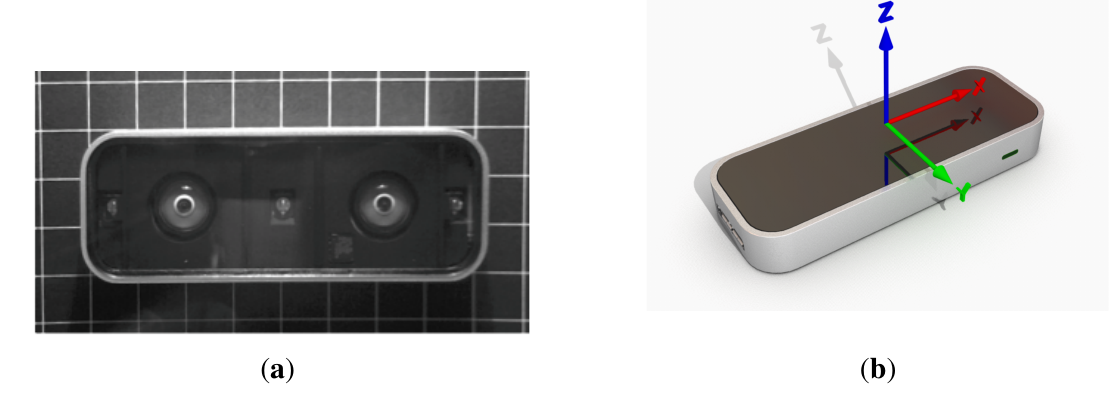
Figure 1. Visualization of a ( a ) real (using infrared imaging) and ( b ) 3D model of the Leap Motion Controller with the coordinate